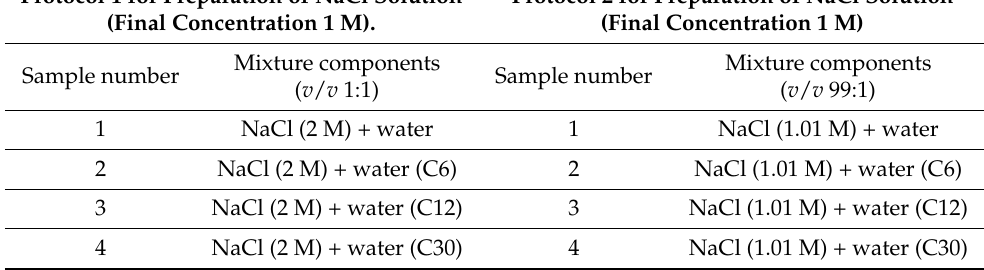
Table 1. Test solutions. Protocol 1 for Preparation of NaCl Solution (Final Concentration 1